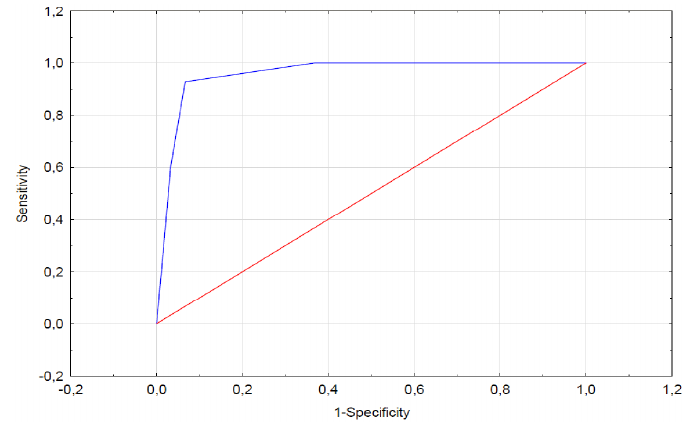
Figure 2. Receiver operating characteristic for the dividend payment (Area under curve: 0.958333; Gini: